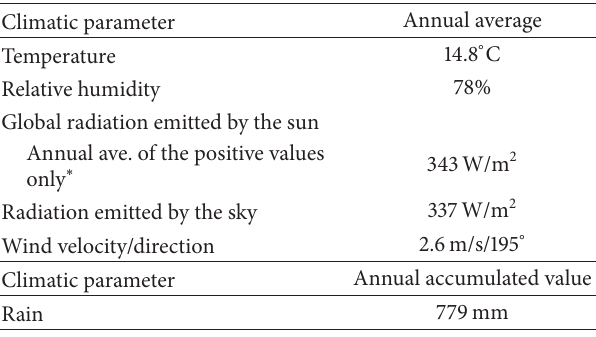
Table 4: Porto climate generated by the commercial software Meteonorm 6